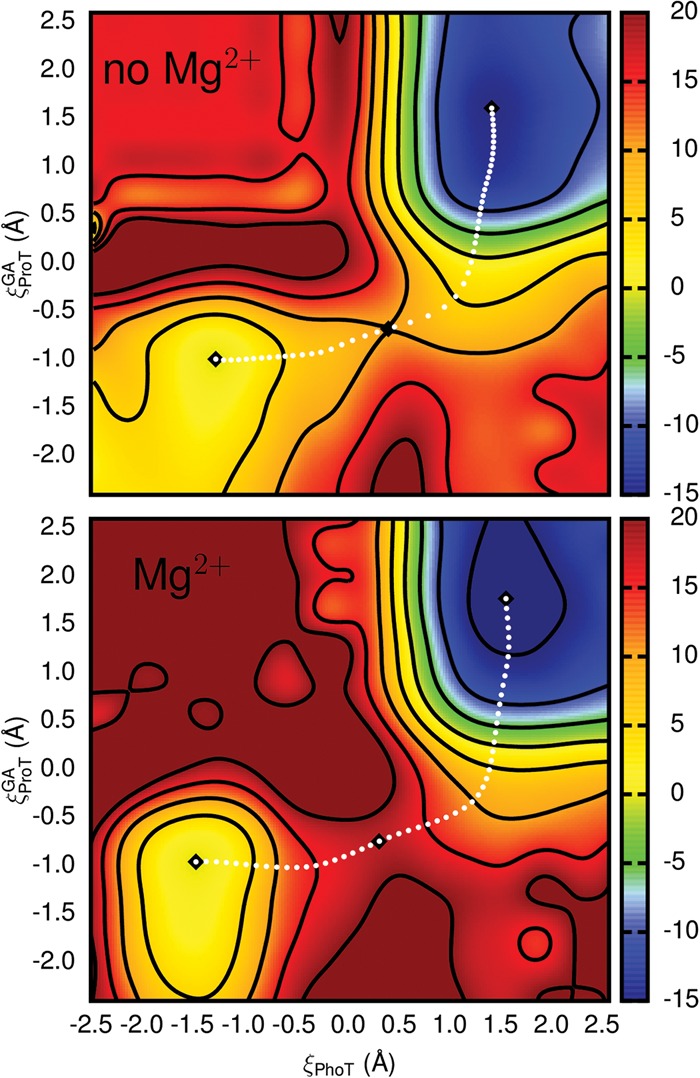
Free energy surfaces of the HDVr catalytic reaction starting from an activated (post-base) state with (bottom) and without (top) Mg2+ bound at the position hypothesized by Chen et al. (2010). Axis and abscissa correspond to atom transfer coordinates for general acid proton transfer and phosphoryl transfer (ξProTGA and ξPhoT, respectively). Free energies are in kcal/mol relative to the reactant minima with 5 kcal/mol separation of contour lines. Minima and saddle points (black diamonds) and a minimum free energy path (white dots) are also shown.